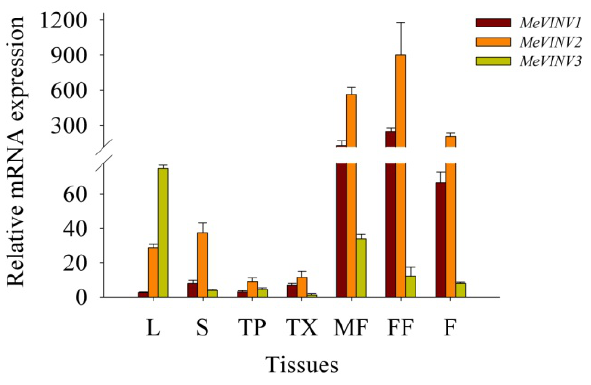
Figure 9. Expression profiles of MeVINVs in cassava organs or tissues. The amount of MeVINV mRNA was normalized by tubulin mRNA, and the expression of MeVINV3 in tuber xylem was used as a calibrator. Each value is the mean ± SE of three independent biological replicates. Notes: L, Leaf, S, Stem, TP, Tuber phloem, TX, Tuber xylem,